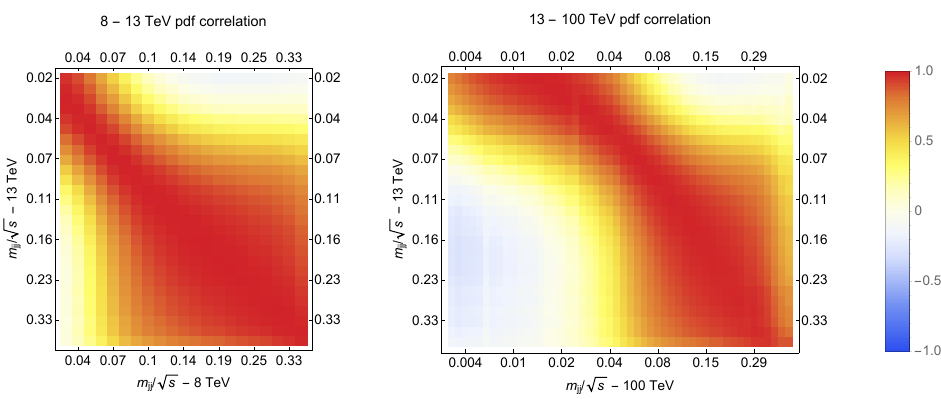
Figure 5 . PDF correlation extracted from the S no-jet set for the dijet analysis. We show how the PDF uncertainty is correlated across di(cid:11)erent invariant mass bins and collider energies (8 - 13 TeV on the left and 13 -100 TeV on the right). The correlation is maximal for bins with similar values p of m jj = s